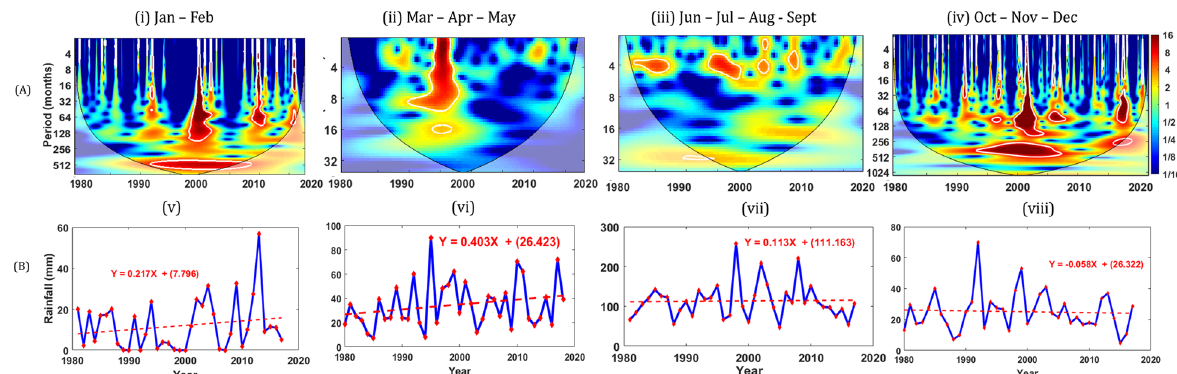
Fig. 4 A Wavelet transforms of monthly rainfall for (i) Jan – Feb, (ii) Mar-Apr-May, (iii) Jun-Jul-Aug-Sept, and (iv) Oct-Nov-Dec. The black line represents the cone-of-influence and white contours represent the 95% significance level; B Annual trend of seasonal maximum rainfall over Bhubaneswar from 1980 to 2018 for (v) Jan – Feb, (vi) Mar-Apr-May, (vii) Jun-Jul-Aug-Sept, and (viii) Oct-Nov-Dec.